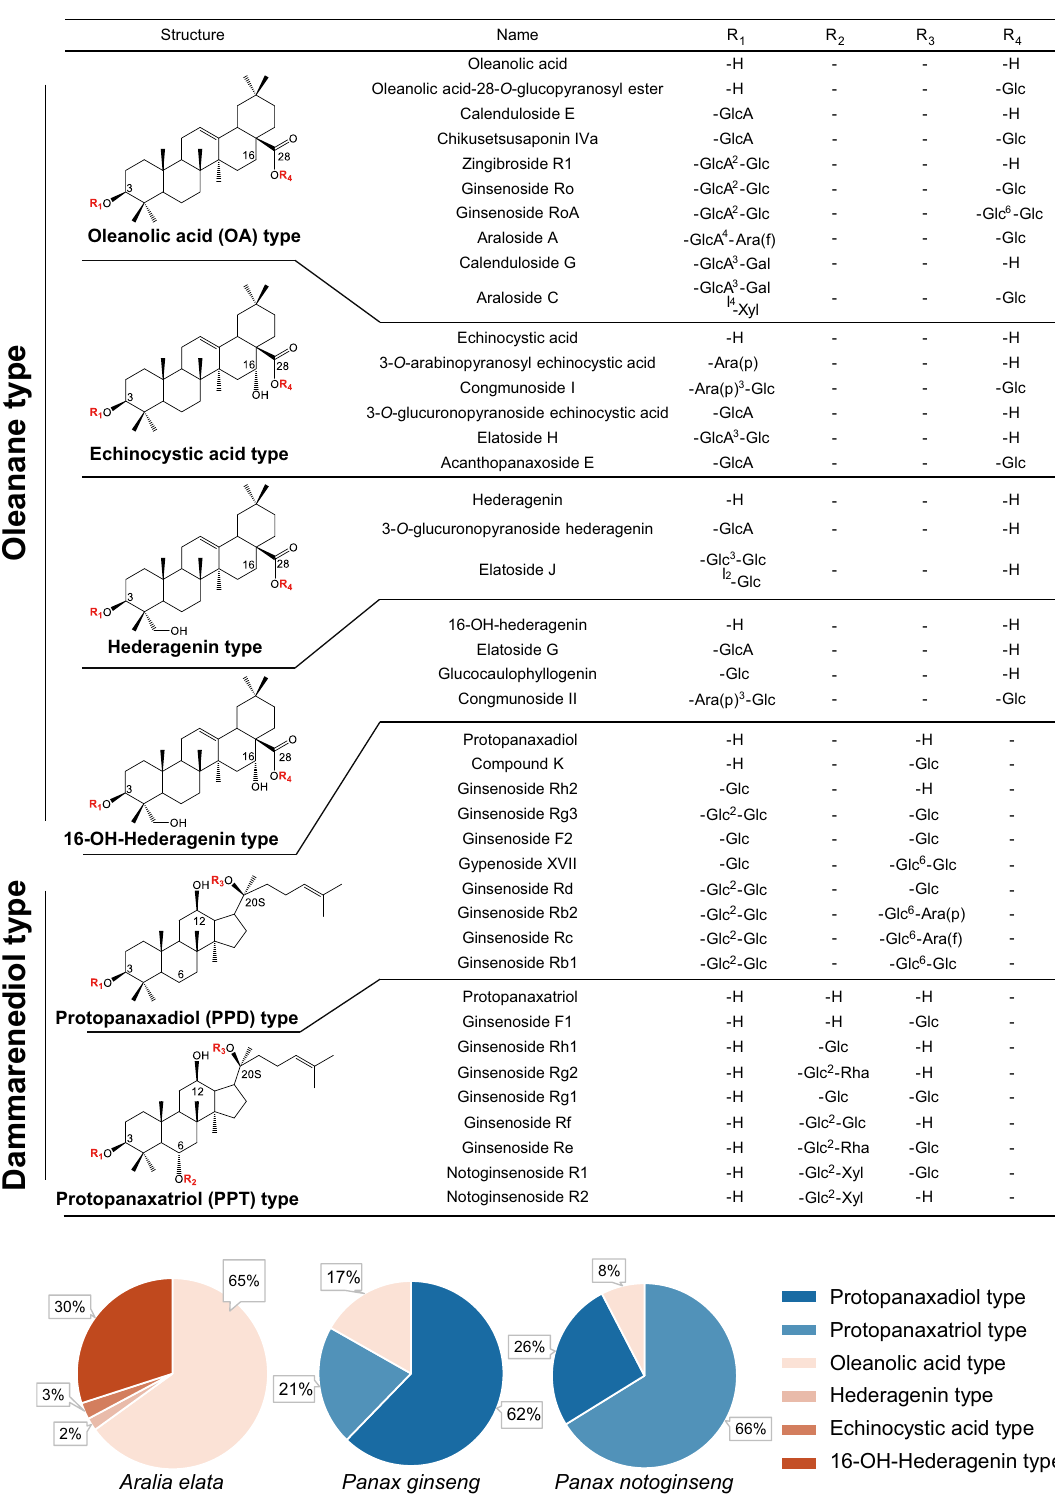
Fig. 1 Structural and compositional variations in triterpenoid saponins among Panax and Aralia genera. a Structures of different types of triterpene saponins isolated from A. elata , P. ginseng , and P. notoginseng . Glc D-glucopyranosyl, GlcA D-glucuronopyranosyl, Gal D-galactopyranosyl, Ara(p) L-arabinopyranosyl, Ara(f) L-arabinofuranosyl, Rha L-rhamnopyranosyl, Xyl D-xylopyranosyl. b Compositional variations in saponins with different triterpene skeletons in A. elata , P. ginseng , and P. notoginseng . The major triterpene pro fi les from a mixture of leaves, stems, and roots were determined using LC – MS. Source data underlying b are provided as a Source Data fi